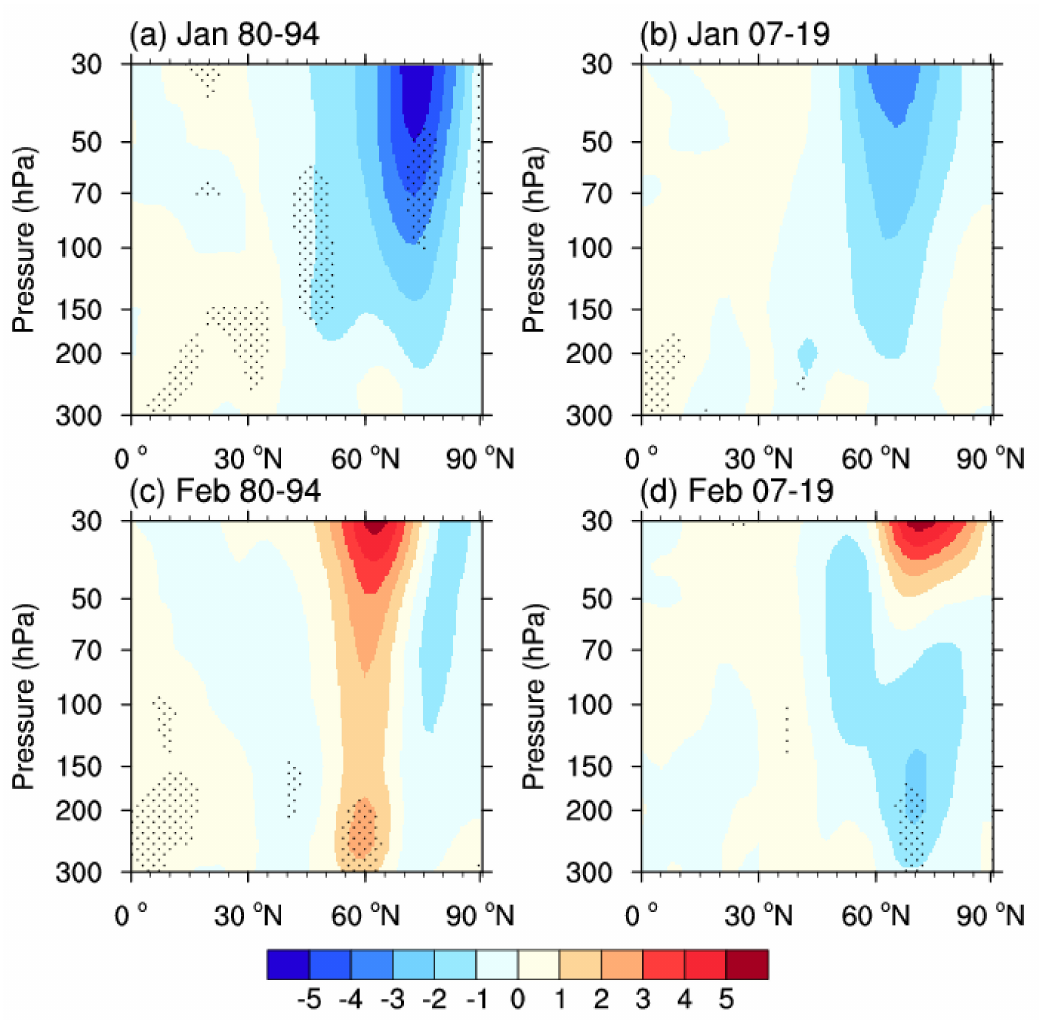
Figure 7. Anomalies in the eddy heat flux (contours; units: K m s − 1 ) based on the regression of AO index in January during ( a ) 1980–1994 ( b ) 2007–2019. ( c , d ) Same as ( a , b ), but for the anomalies in February. The values over the stippled regions are statistically significant at the 95% confidence